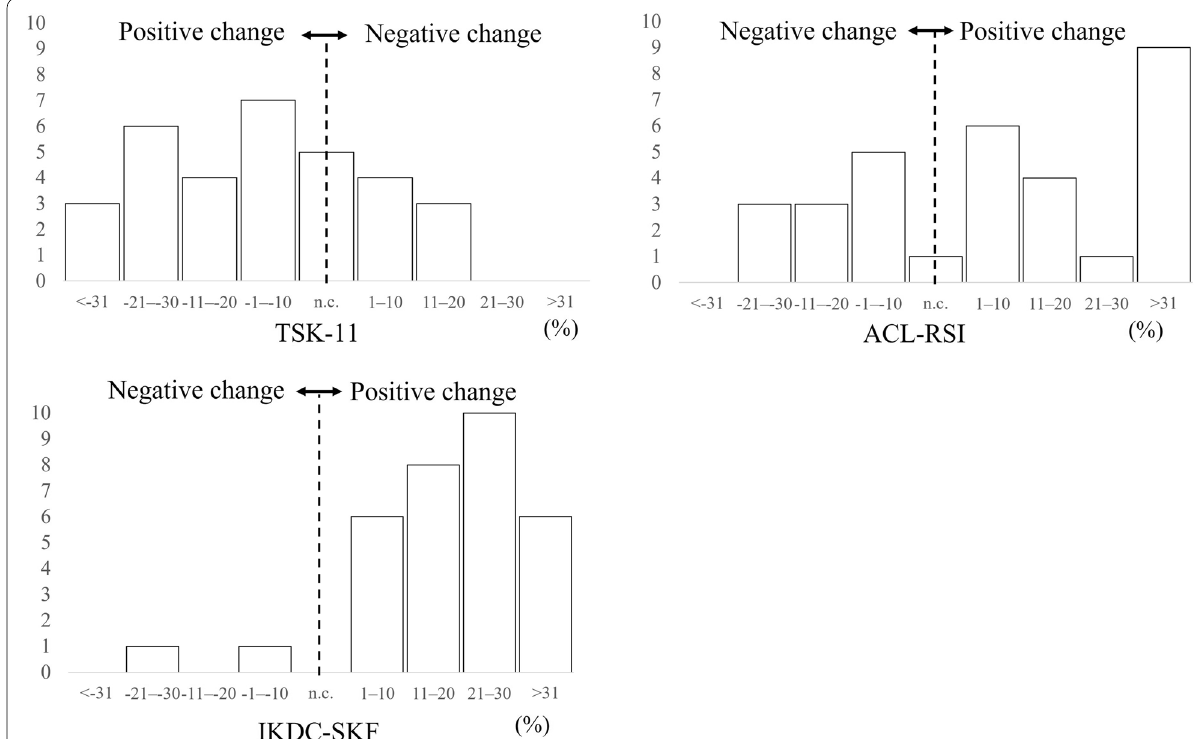
Fig. 2 Percentage changes in the scores from pre-ACLR to 6 months post-ACLR. ACLR, anterior cruciate ligament reconstruction; TSK-11, Tampa Scale for Kinesiophobia-11, ACL-RSI: Anterior Cruciate Ligament Return to Sport after Injury scale; IKDC-SKF, International Knee Documentation Committee Subjective Knee Form; n.c., no change. The x-axis shows the change in the score from pre-ACLR to 6 months post-ACLR. The y-axis shows the frequency. A positive change was defined as an increase in IKDC-SKF and ACL-RSI scores and a decrease in TSK-11 score